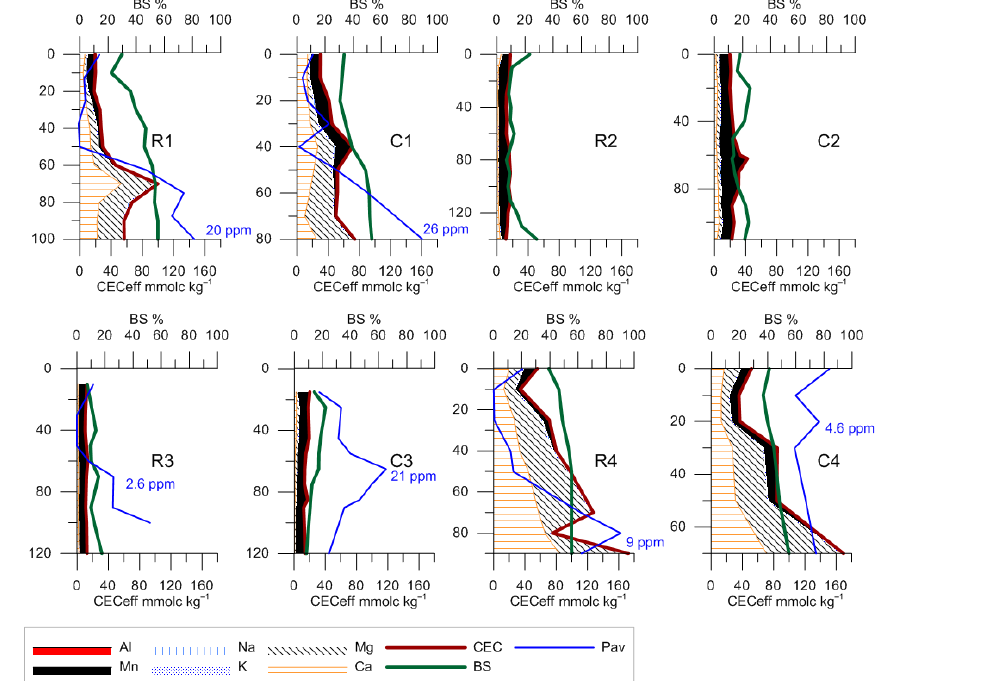
Figure 7. Down-profile variations of available cations (CEC), base saturation (BS) and phosphorous (Pav).